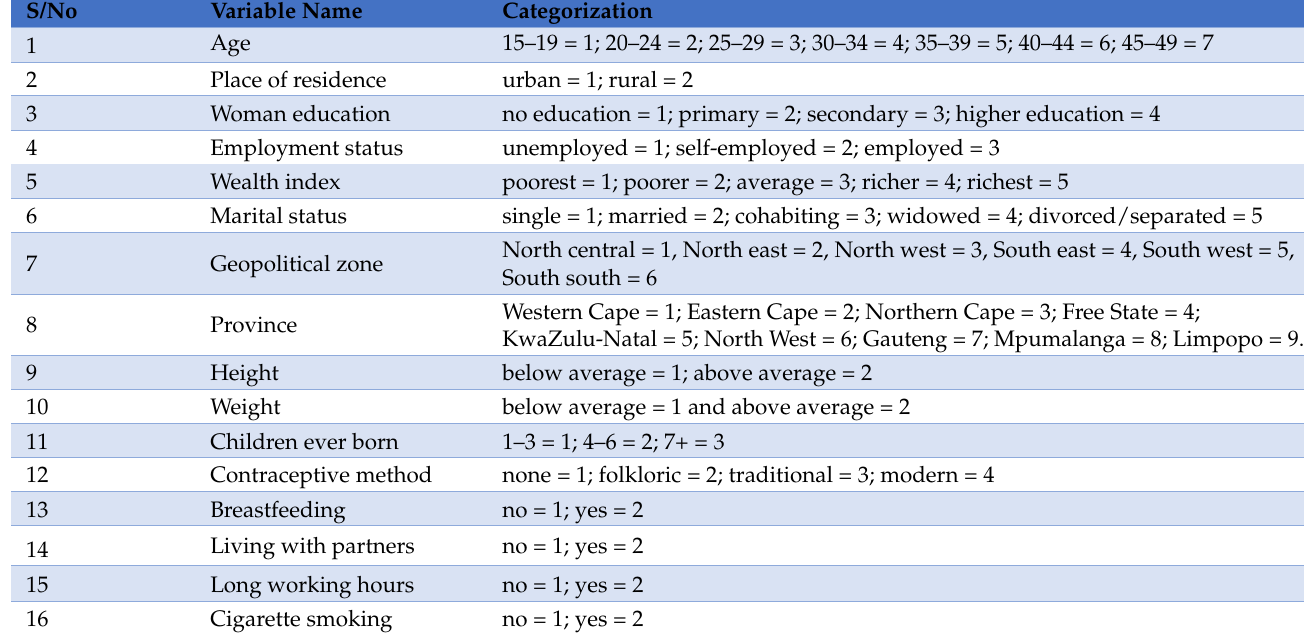
Table 1. Summary of independent variables measured in this